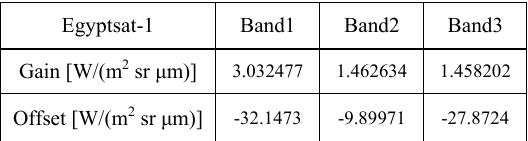
Table 4: The estimated radiometric calibration coefficients for Egyptsat-1 Atmospheric correction is the process of removing/